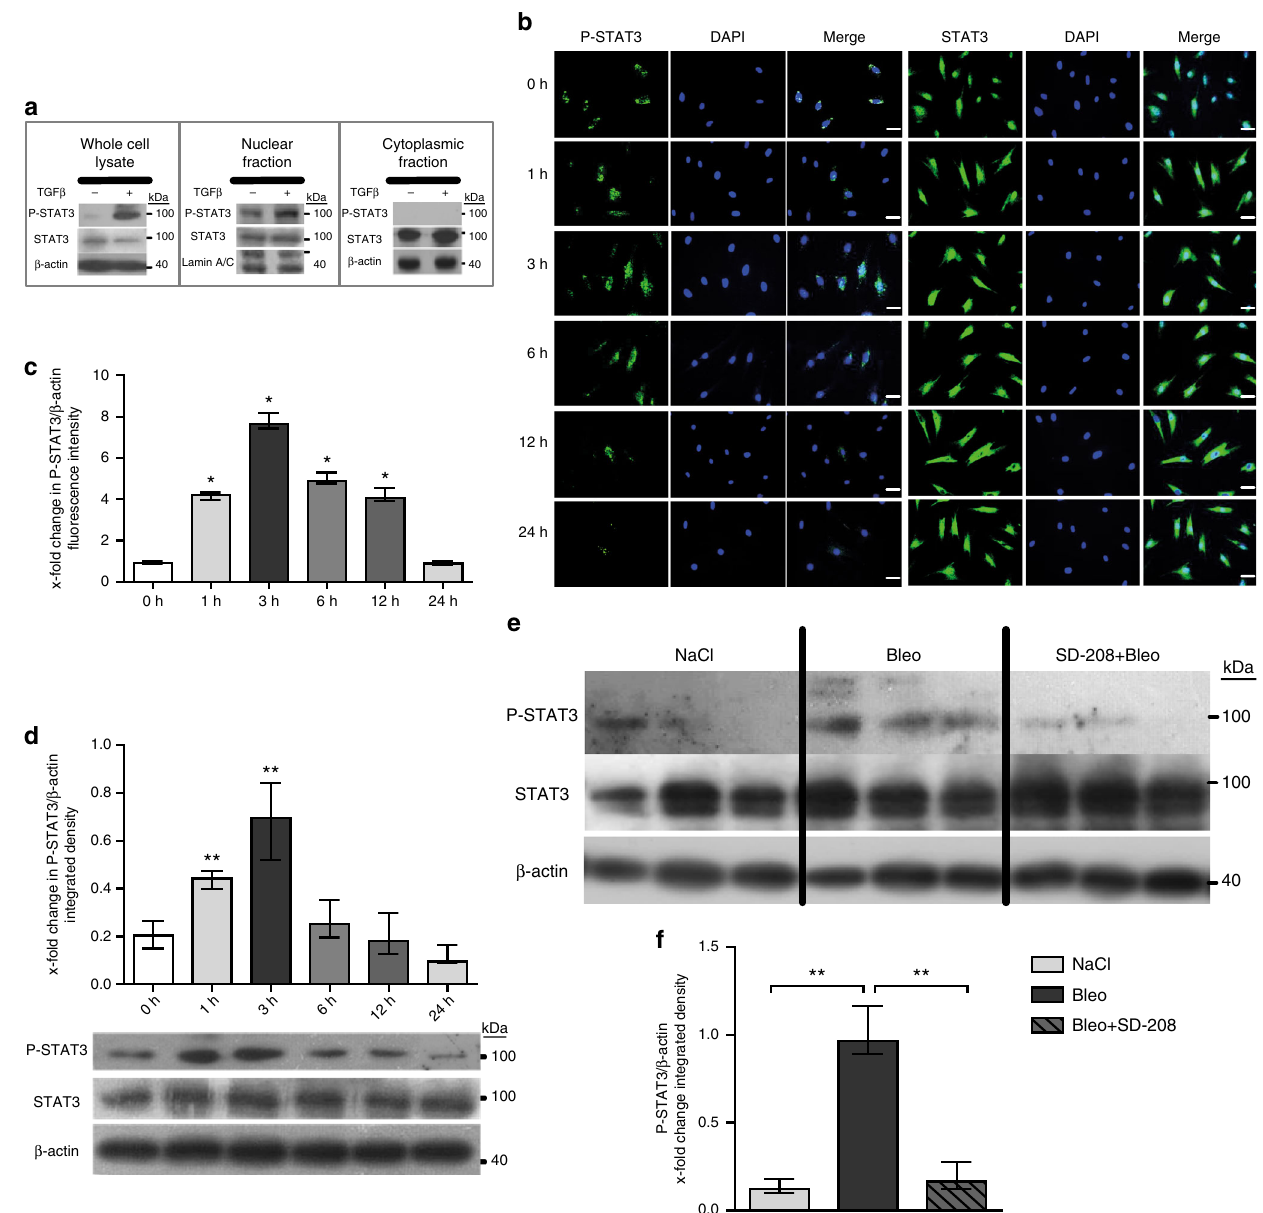
Fig. 2 TGF β activates STAT3 signaling in fi broblasts. a Total nuclear and cytoplasmatic levels of P-STAT3 and total STAT3 in human dermal fi broblasts stimulated for 1 h with TGF β as analyzed by western blot ( n ≥ 4 and 2 technical replicates). b – d Time-dependent changes in the levels of P-STAT3 as evaluated by b immuno fl uorescence staining and c quanti fi cation further con fi rmed by d western blot ( n ≥ 5 for all). e , f Levels of P-STAT3 in fi broblasts in bleomycin-challenged mice, treated with SD-208, a selective TGF β receptor type 1 kinase inhibitor ( n ≥ 4 with 2 technical replicates for all groups) analyzed by e western blot and f its quanti fi cation. Representative blots and images (200-fold magni fi cation; horizontal scale bar, 100 μ m) are shown. Expected band size for P-STAT3 and STAT3 are 79 kDa (lower faint band) and 86 kDa (higher intense band) and the ladder represents 100 kDa. Beta-actin expected molecular weight/size is 42 kDa. Results are shown as median ± interquartile range (IQR). * P < 0.05, ** P < 0.01 vs. healthy dermal fi broblasts or unstimulated/untreated control fi broblasts, or vehicle-treated, fi brotic mice, fi broblasts (Fig. 2b – c). Furthermore, selective inhibition of TGF β activation of JAK2, JNK, SRC, and c-ABL signaling in SSc with increased staining for P-JAK2 (Tyr-1007/1008), P-JNK signaling by SD-208, a TGF β receptor I inhibitor 33 , prevents the upregulation of P-STAT3 in bleomycin-challenged mice (Fig. 2e – f). Taken together, these results demonstrate that P-STAT3 is over- expressed in SSc fi broblasts in a TGF β -dependent manner. and c-ABL kinases jointly activate manner (Fig. 3c, d). We thus inhibit JAK2, SRC, JNK, and c-ABL, STAT3 signaling in fi broblasts in response to TGF β . We next all of which have also been demonstrated to phosphorylate evaluate which upstream kinases mediate phosphorylation of STAT3 and are known to transduce the pro- fi brotic effects of STAT3 in response to TGF β . Immuno fl uorescence staining shows